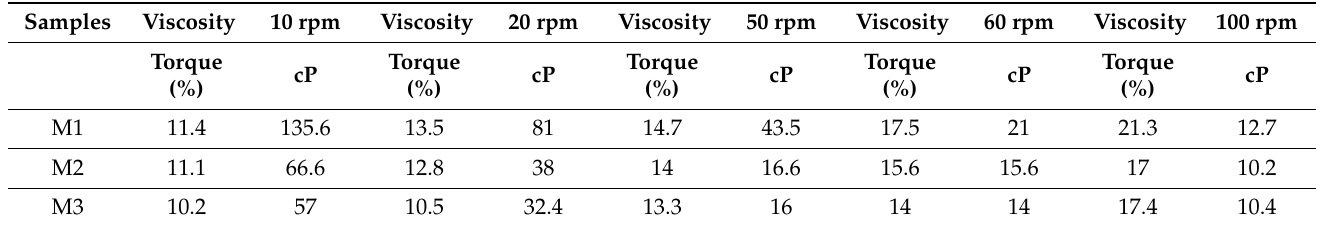
Table 1. Viscosities of hydrogels with different concentrations (M1, M2, and M3).